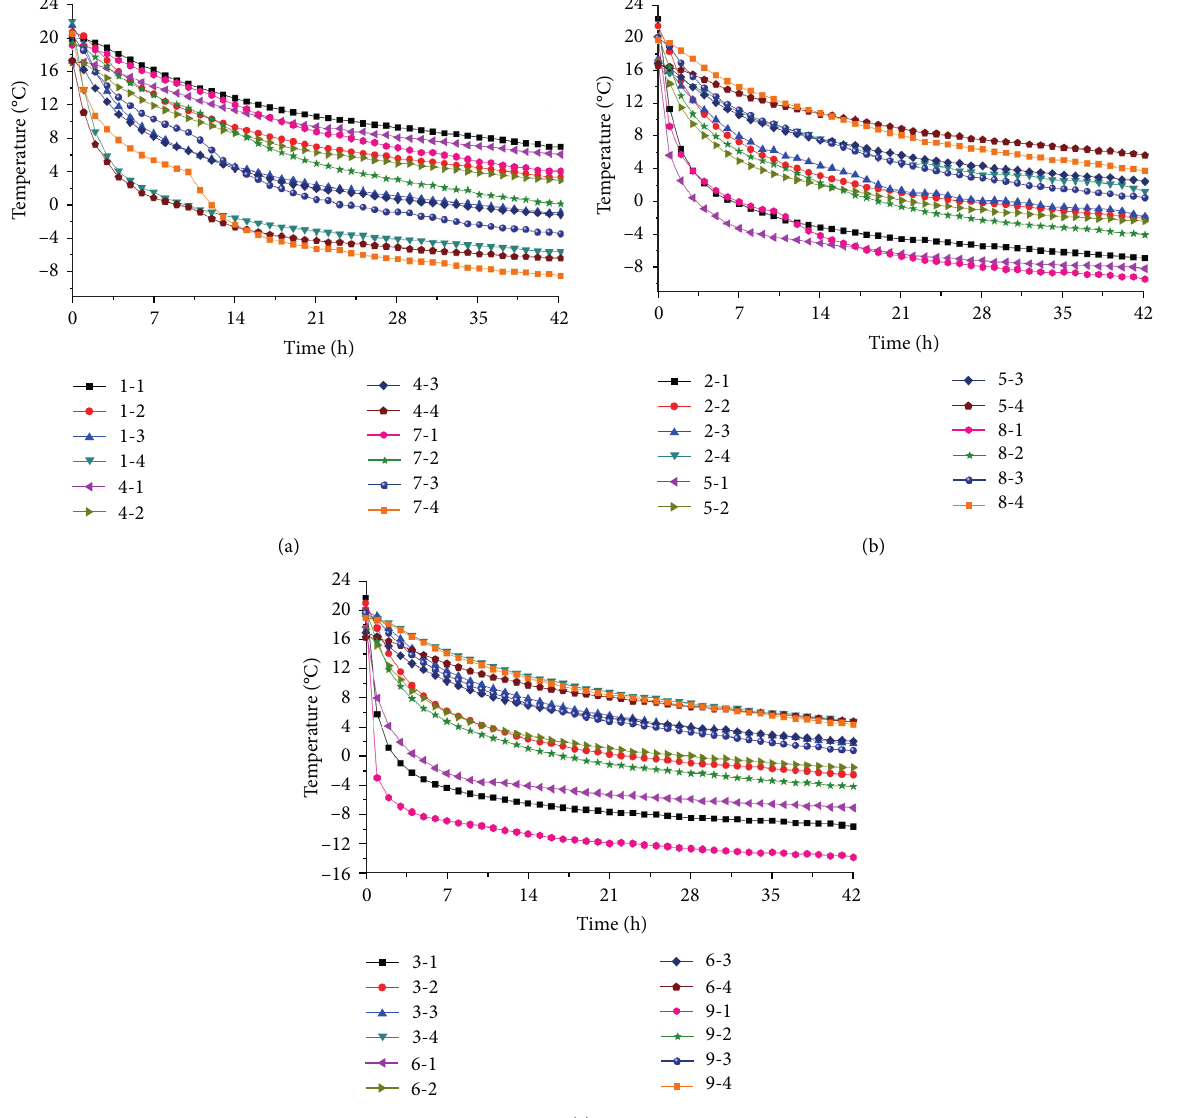
Figure 9: Temperature-time curves of SCF, EDCF, and ESF: (a) 90 ° monitoring points; (b) 45 ° monitoring points; (c) 0 ° monitoring